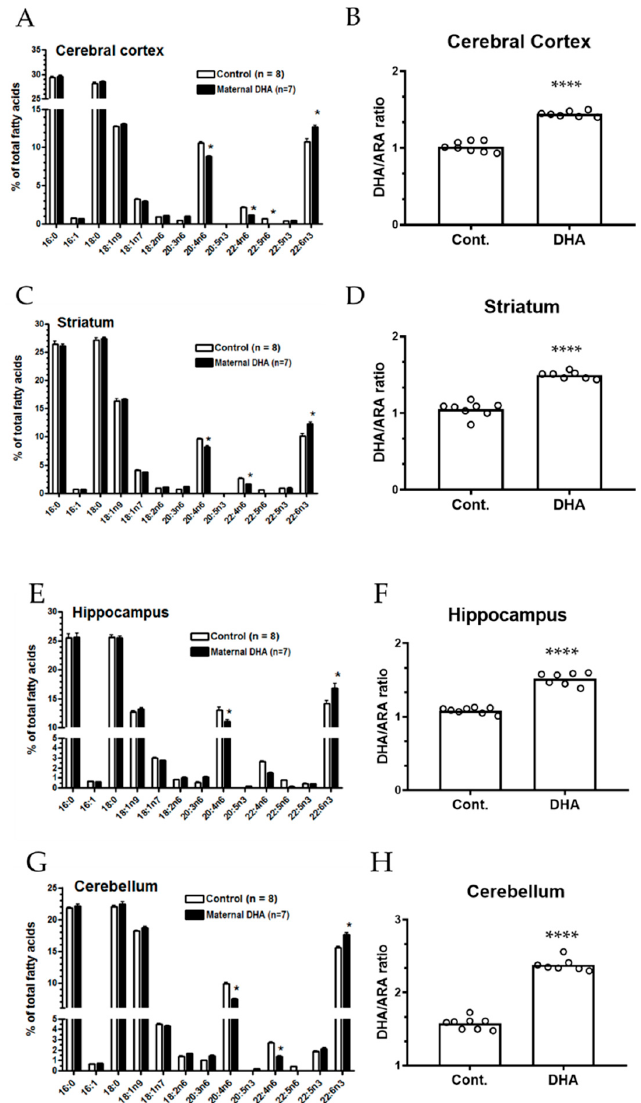
Figure 4. Maternal DHA intervention alters the fatty acid (FA) composition in offspring brain regions. ( A , C , E , G ): FA composition from different brain regions (cortex, striatum, hippocampus, and cerebellum, respectively) of developing pups nursed by mothers fed a control and 1% DHA diet. ( B , D , F , H ): Ratios of DHA/ arachidonic acid (ARA) in different brain regions (cortex, striatum, hippocampus, and cerebellum, respectively). FA composition was reported as percent of total FA content (g per 100 g). Each value represents the mean ± SEM of eight and seven pups from control and 1% DHA diet groups, respectively. Analysis of FA using one way-ANOVA indicated significance between 1% DHA diet group and controls. * p < 0.05. Analysis of DHA/ARA ratios using two-tail unpaired t-test indicated significance between DHA group and controls. **** p < 0.0001.